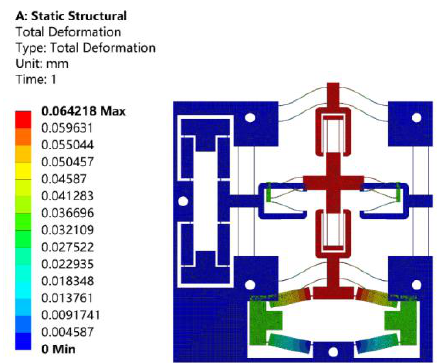
Figure 11. Analysis of the displacement amplification ratio by ANSYS.